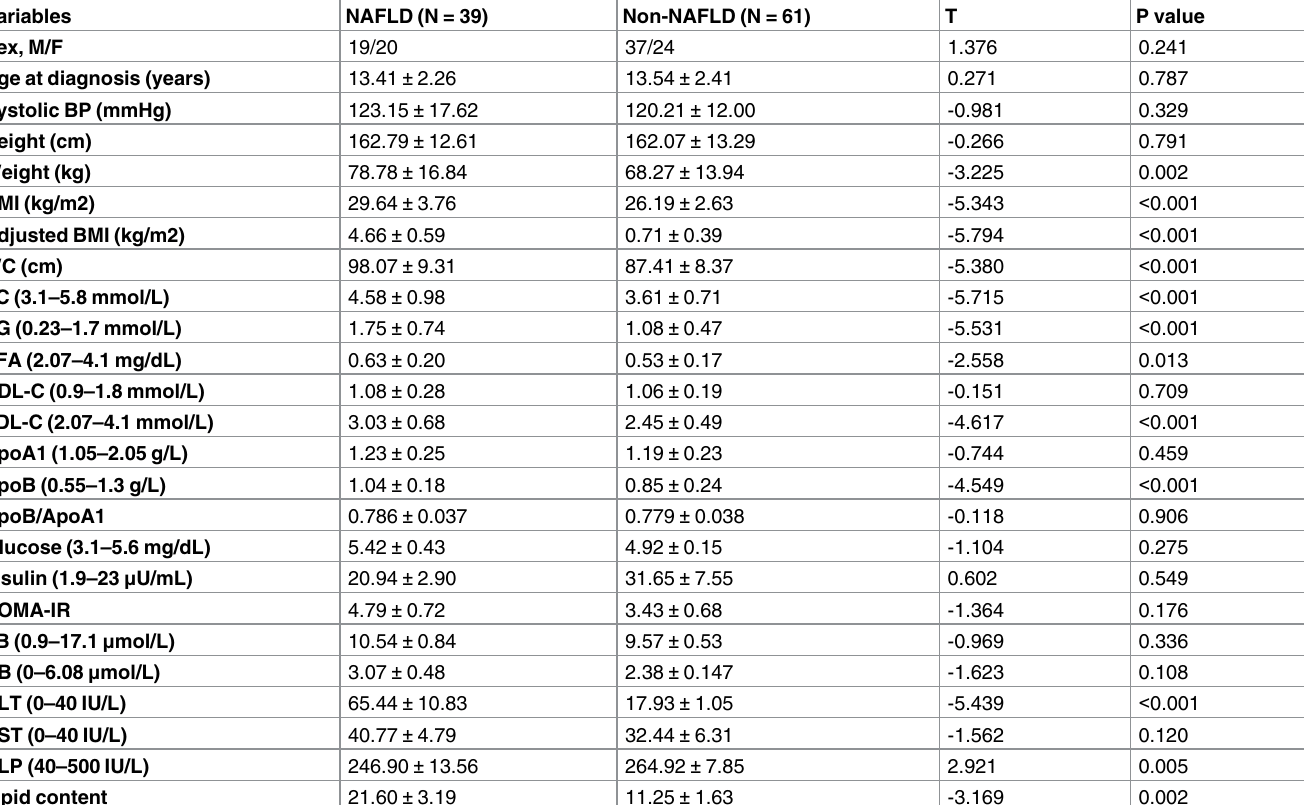
Table 1. Anthropometric and biochemical charactersin NAFLD and non-NAFLD groups (of Han Chinese ethnicity).